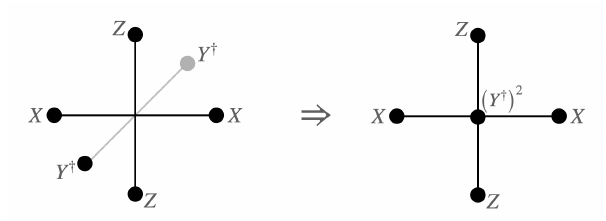
Figure 2: The octahedron operator in the Chamon code (in the left) is squeezed into the xz plane (in the right).